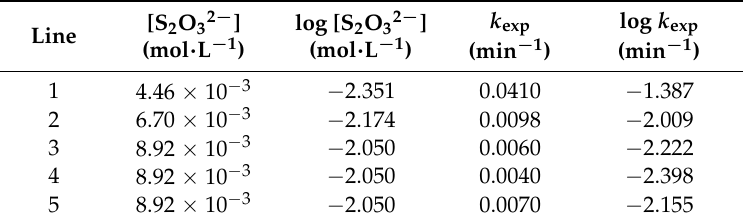
Table 4. Reaction order with respect to the initial thiosulfate concentration.